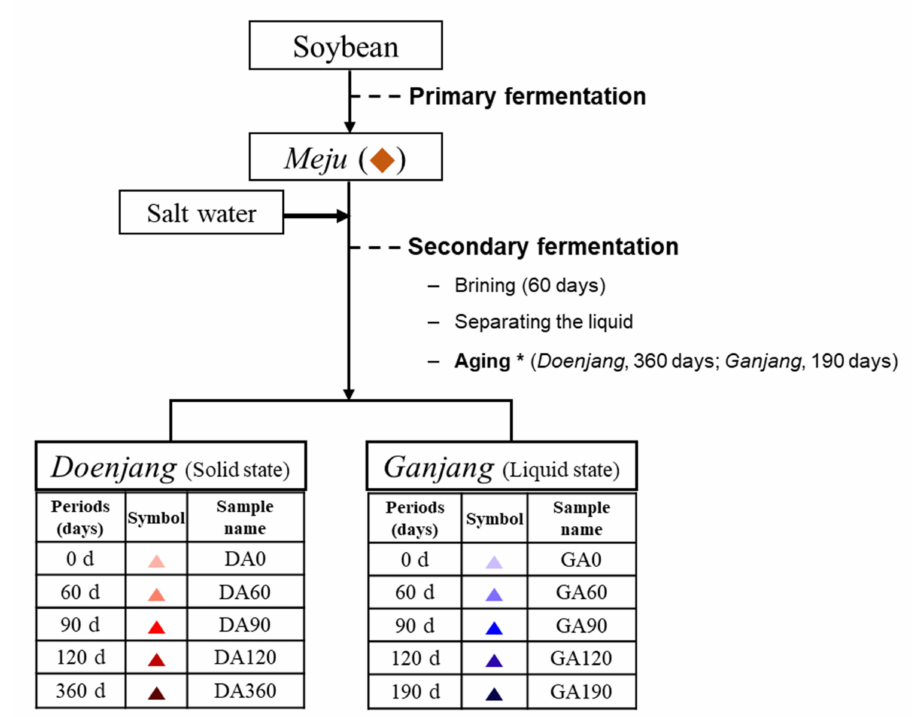
Figure 1. Overview of the processes involved in the production of doenjang and from meju (primary fermented product). Different processes indicated as: meju ( (cid:7) ), doenjang aging (0 d: (cid:78) ; 60 d: (cid:78) ; 90 d: (cid:78) ; 120 d: (cid:78) ; 360 d: (cid:78) ), ganjang aging (0 d: (cid:78) ; 60 d: (cid:78) ; 90 d: (cid:78) ; 120 d: (cid:78) ; 190 d: (cid:78) ). * The period for making final